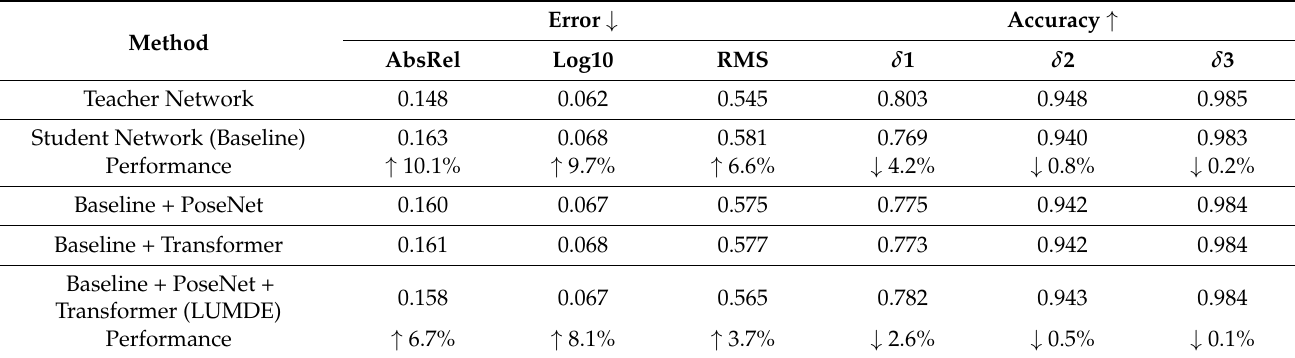
Table 4. Ablation study of different model combinations.